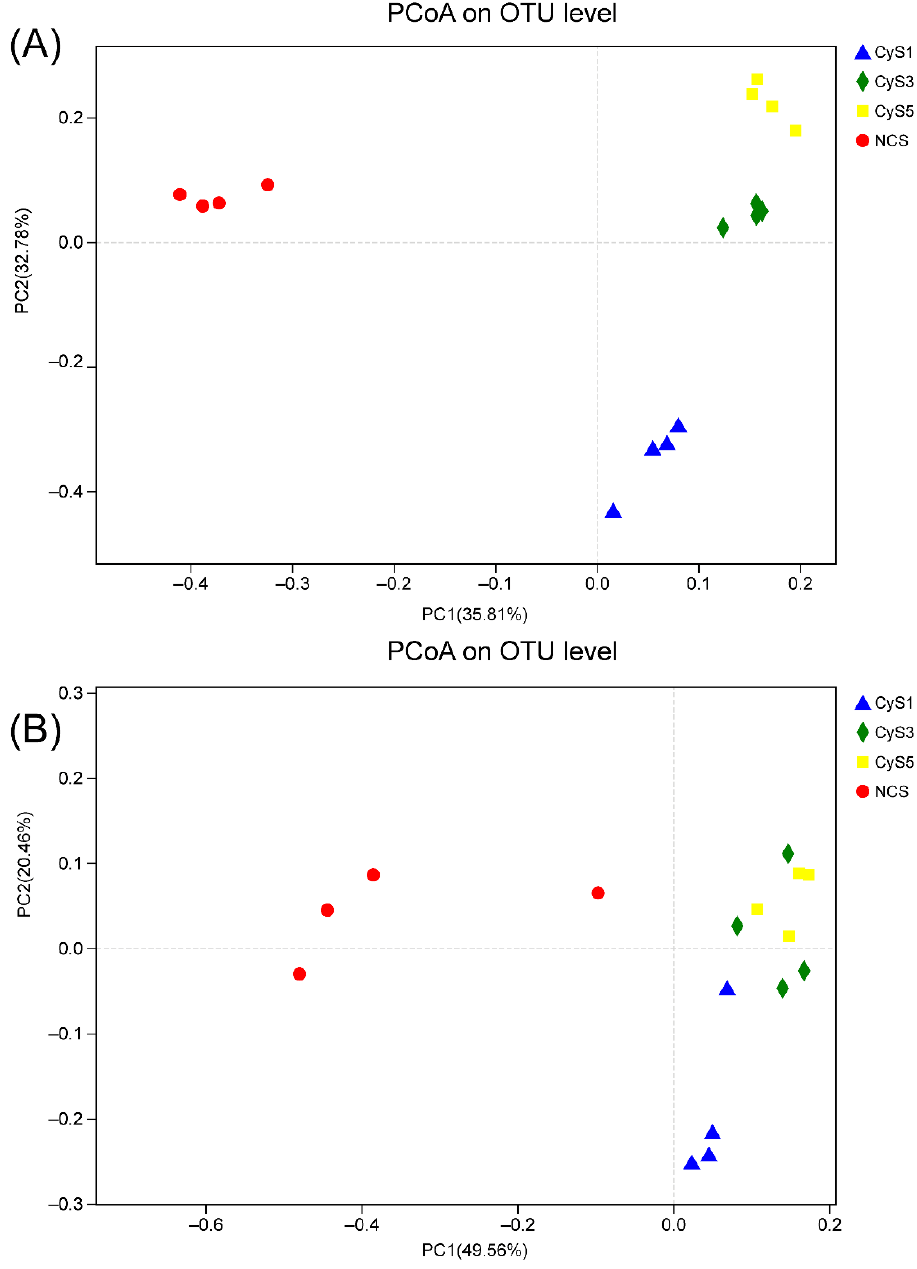
Figure 4. Principal coordinate analysis (PcoA) in winter ( A ) and summer ( B ). NCS, fallow